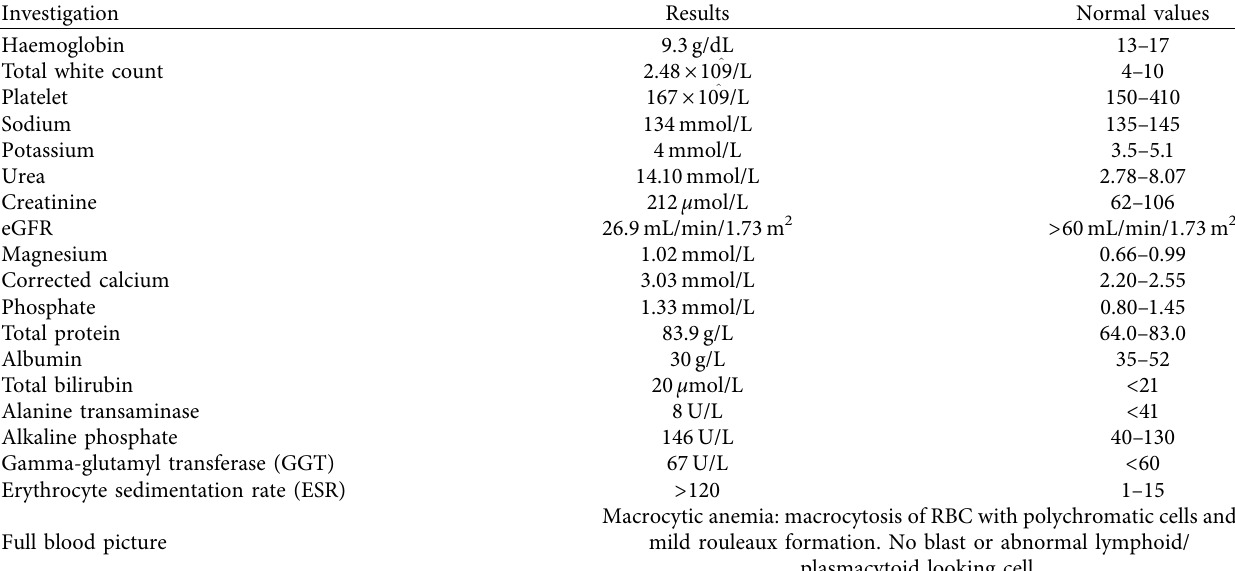
Table 1: Baseline blood